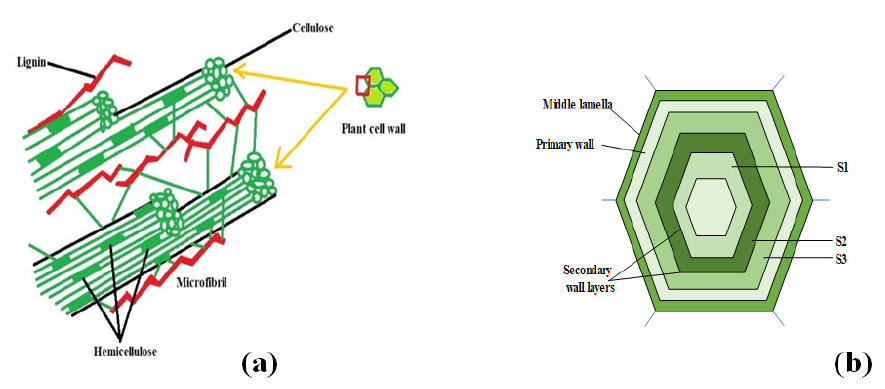
Fig. 1. (a) Plant cell wall structure, (b) Transverse section of plant cell